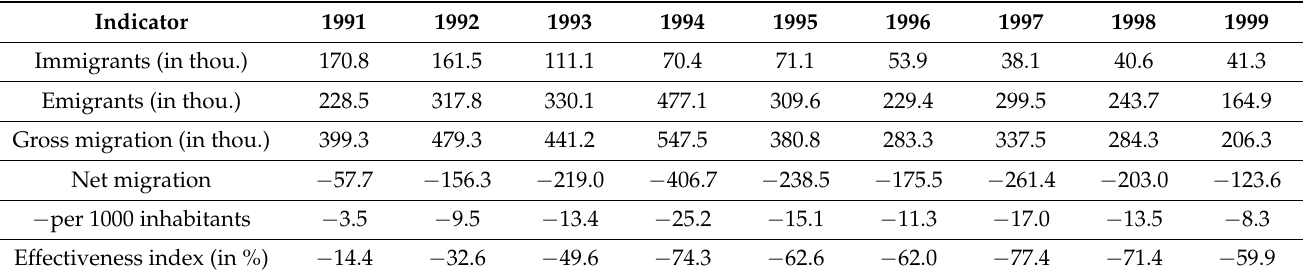
Table 1. Calculations based on the data from the Agency of Statistics of the Republic of Kazakhstan.